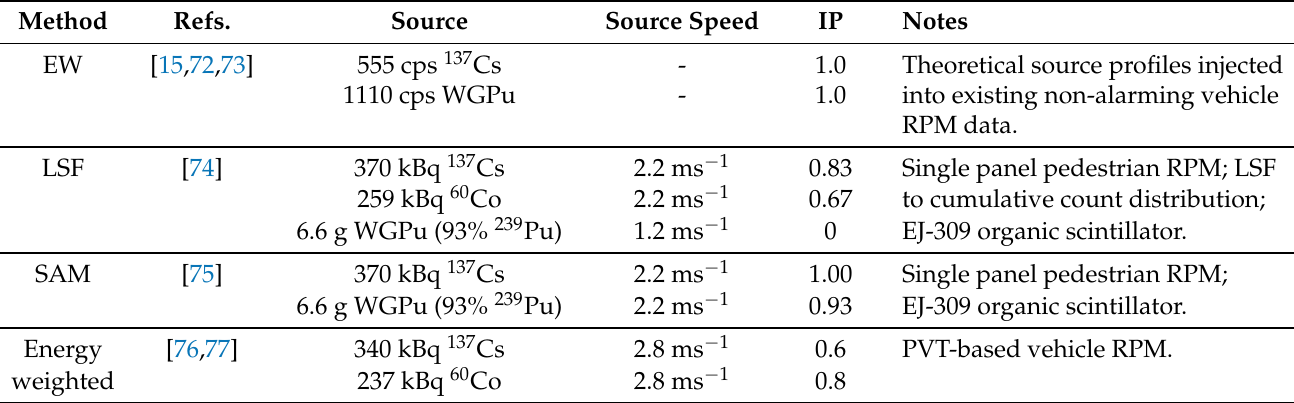
Table 3. Results of energy-based methods for radioisotope identification of sources moving through plastic scintillator-based RPMs. Identification probability (IP) is the probability of the correct radioisotope